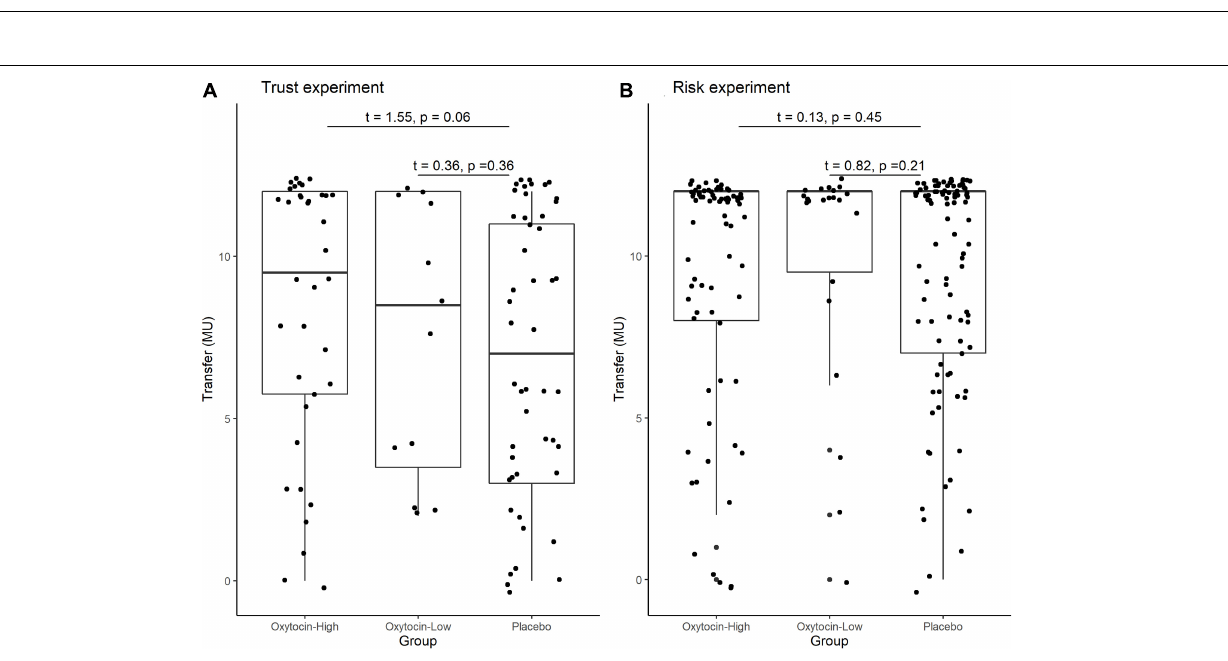
FIGURE 6 | Box plots of average transfer per investor in the trust (A) and risk (B) games, stratified by sensitivity to oxytocin. For each plot, the middle horizontal line denotes the median value; the box extends from the 25th to the 75th percentile values; the vertical lines extending from the box denote adjacent values (i.e., the most extreme values within 1.5 interquartile of the 25th and 75th percentile of each group); and the dots denote the average transfer per investor. The difference in average investment in the trust game was significant neither between the high-sensitivity and placebo groups [8.361 vs. 6.917; t ( 82 ) = 1.55, P = 0.06, one-sided], nor between the low-sensitivity and placebo groups [7.417 vs. 6.917; t -test; t ( 58 ) = 0.36, P = 0.36, one-sided].